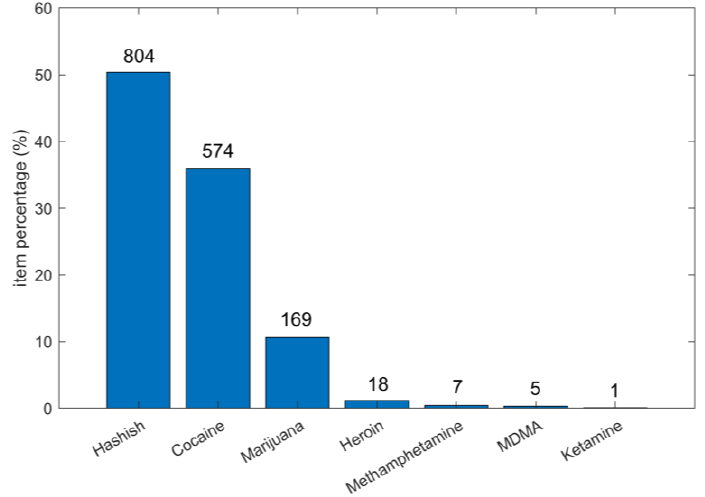
Figure 2. Pareto plot of item percentage for the different categories of street seizures. The total num- ber of items per category is shown at the top of each bar.